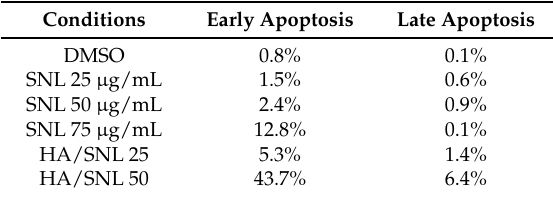
Table 1. Apoptotic levels of A549 cells treated with DMSO, SNL, and HA/SNL